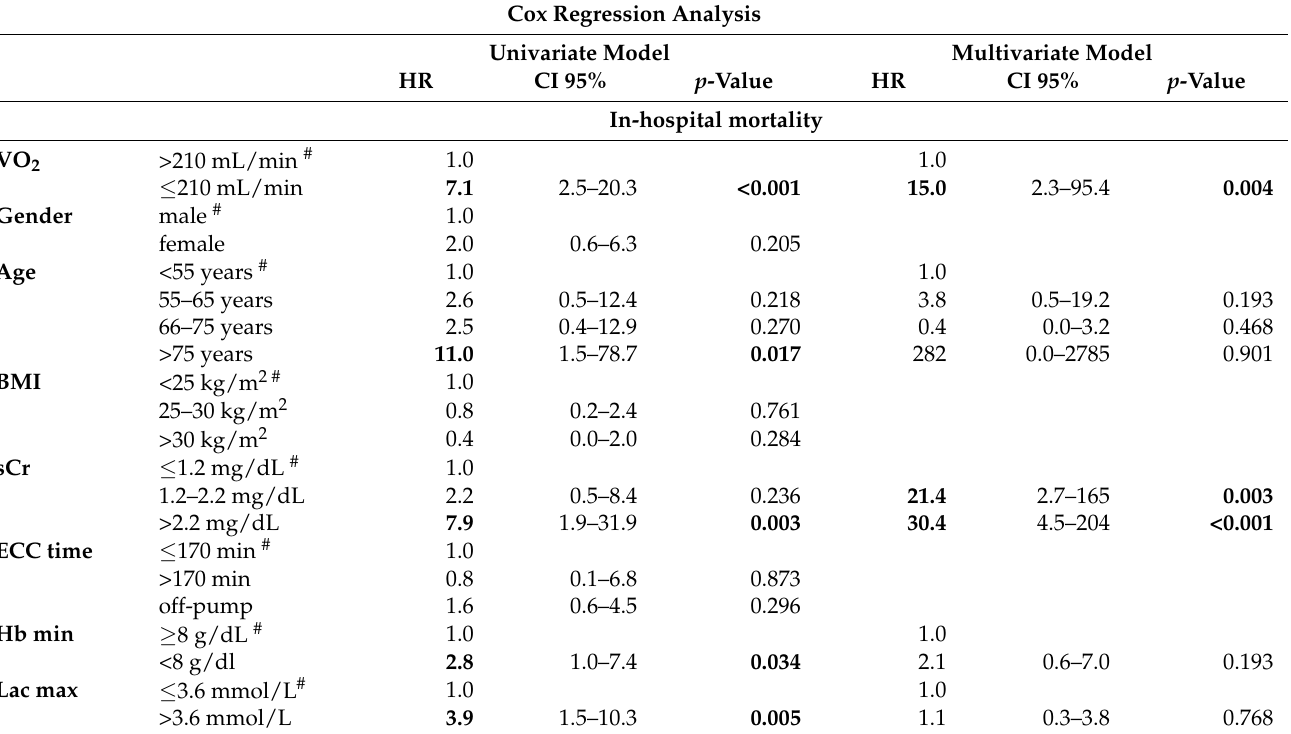
Table 3. Uni- and multivariate cox regression analysis for in-hospital, 1 and 6-year mortality after LVAD Implantation. The univariate model was performed for demographic and periopera- tive characteristics. The multivariate model included only statistically significant categories of the univariate